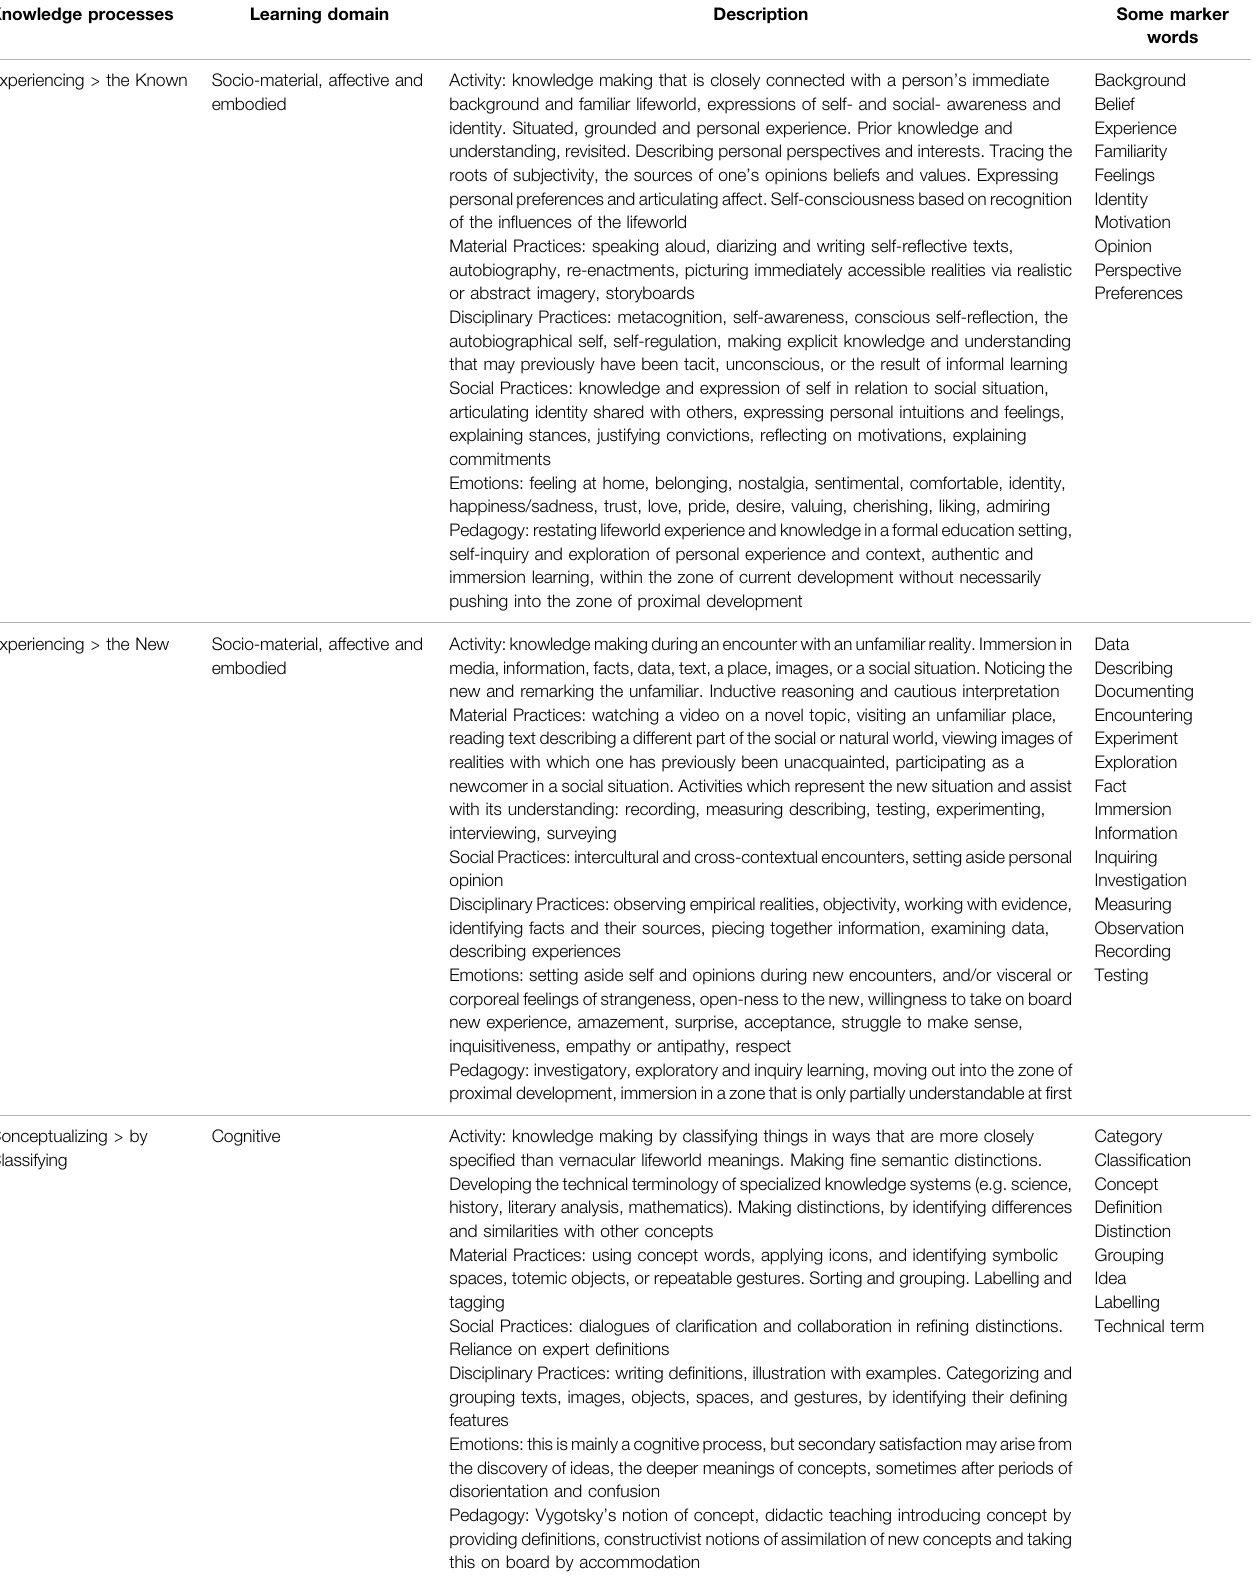
TABLE 1 | Elaboration of knowledge